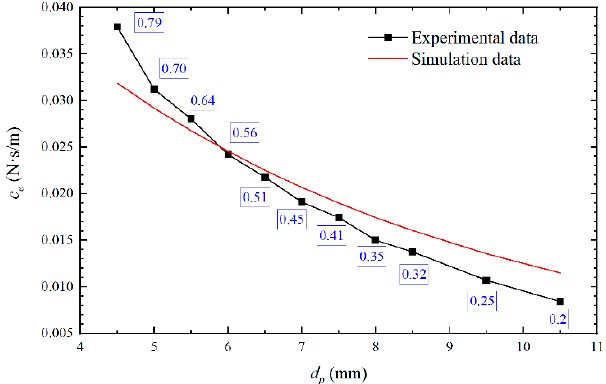
Figure 7. The simulation and experimental damping coefficient as a function of d p .